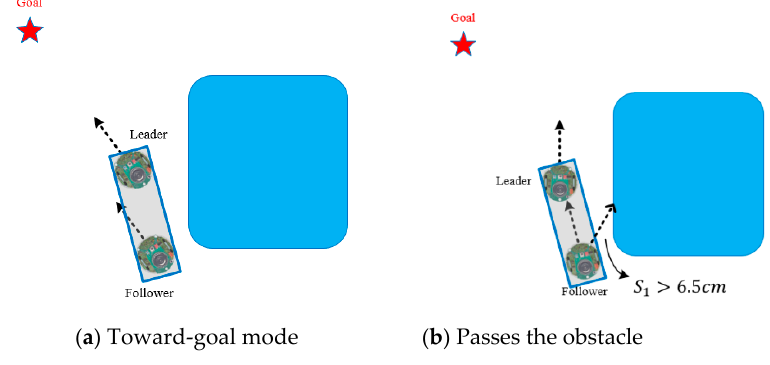
Figure 27. Follower robot encounters an obstacle.